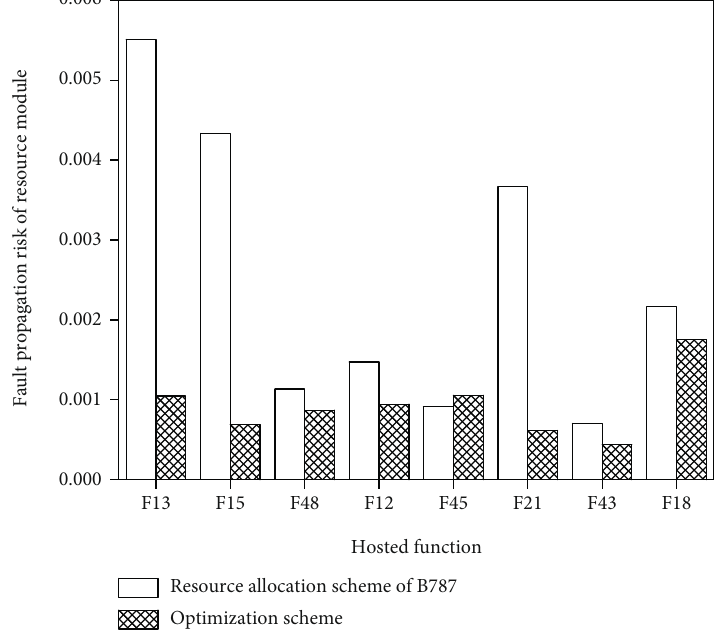
Figure 9: Fault propagation risk for resource module servicing key